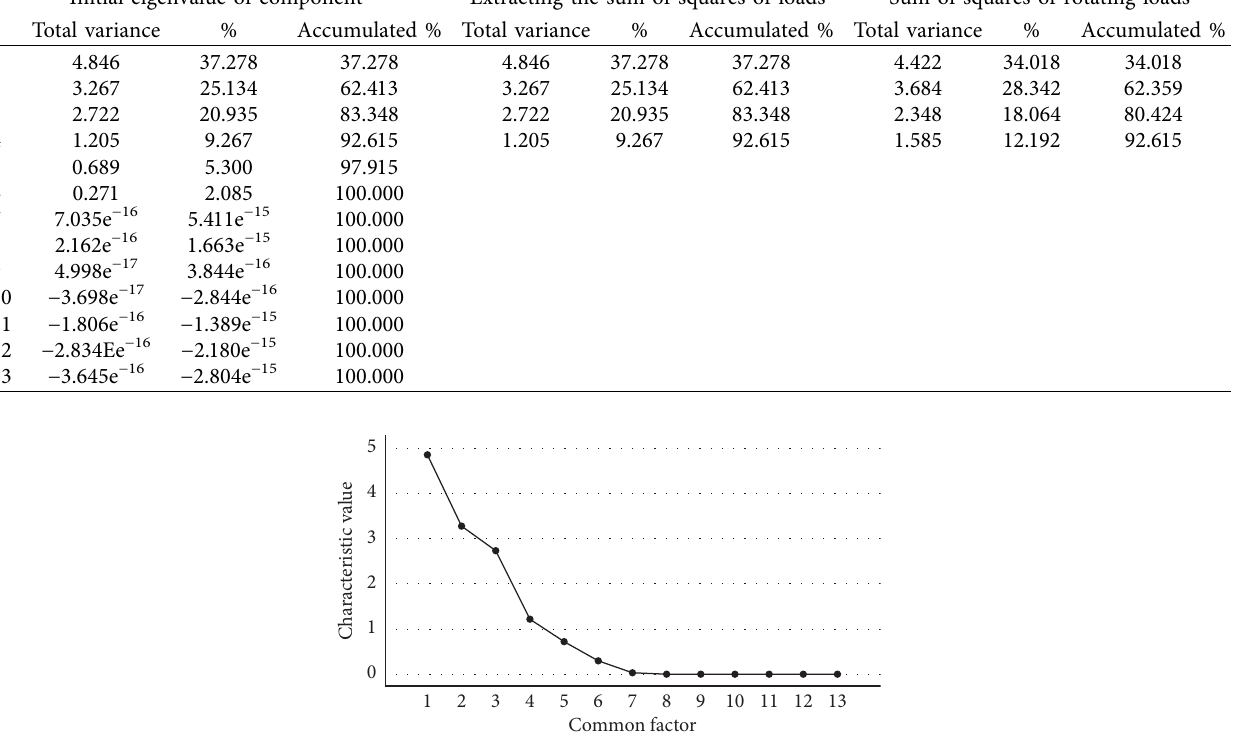
Figure 3: Factor analysis of the incense burner in the Ming Dynasty gravel map. Table 3: Component matrix and composition score coefficient matrix of censers after rotation in the Ming Dynasty.